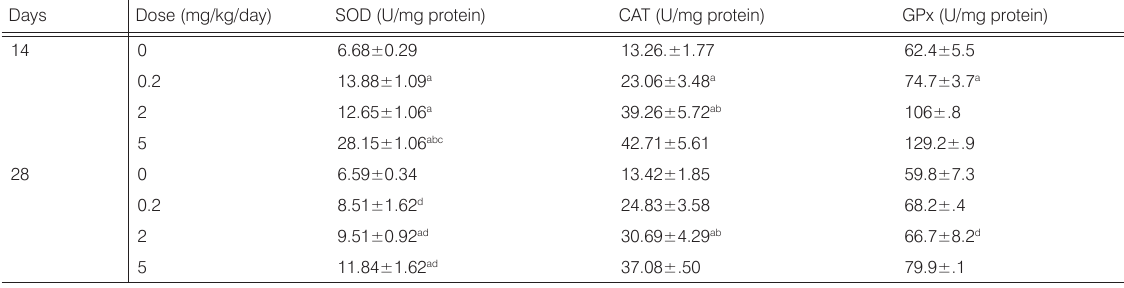
Table 2 Rats brain SOD, CAT and GPx activities in sub-chronic intoxication with chlorpyrifos